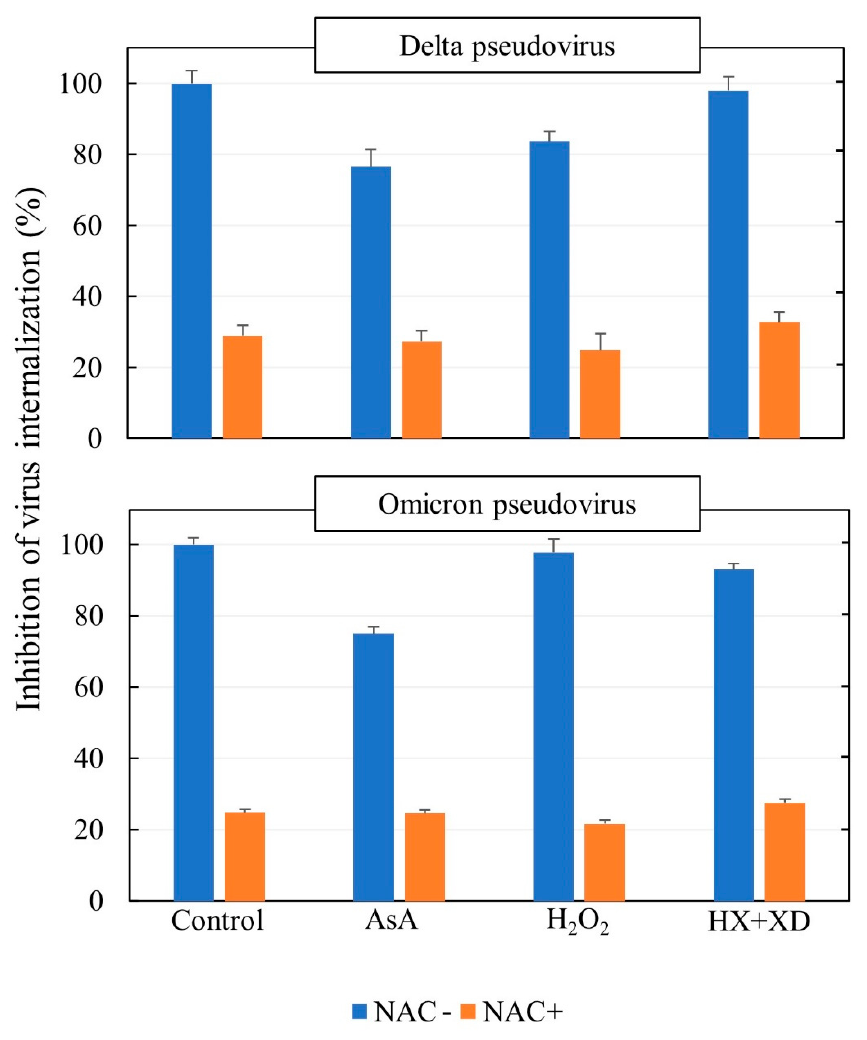
Figure 6. Internalization of Delta and Omicron SARS-CoV-2 pseudoviruses (10,000 TU/culture) into ACE2-HEK293 cells, as related to the treatment of cells with either ascorbic acid (AsA, 200 µ M) or hydrogen peroxide (H 2 O 2 , 50 µ M), or a mixture of hypoxanthine (HX, 31 µ M) and xanthine oxidase (XO, 0.5 mU/mL), and either in the absence or in the presence of NAC (25 mM). The results are the means ± SD of triplicate analyses and are expressed as the percent of the values recorded in virus controls.